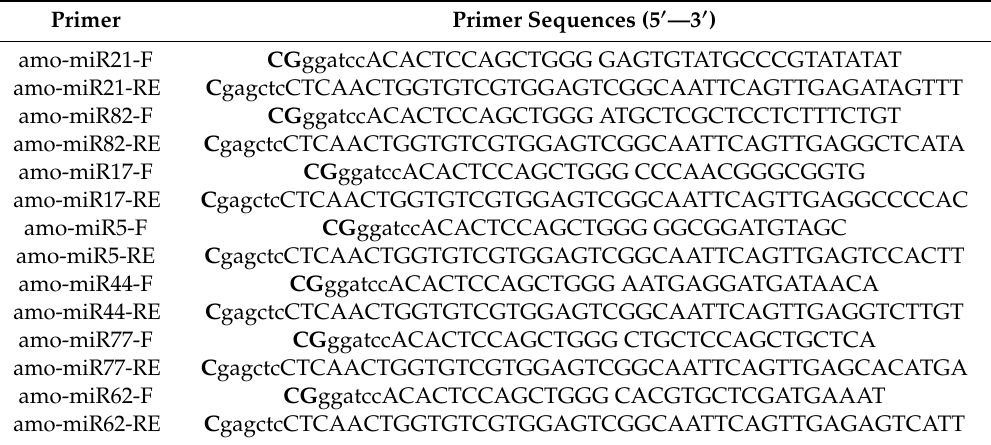
Table 2. Primer sequences for